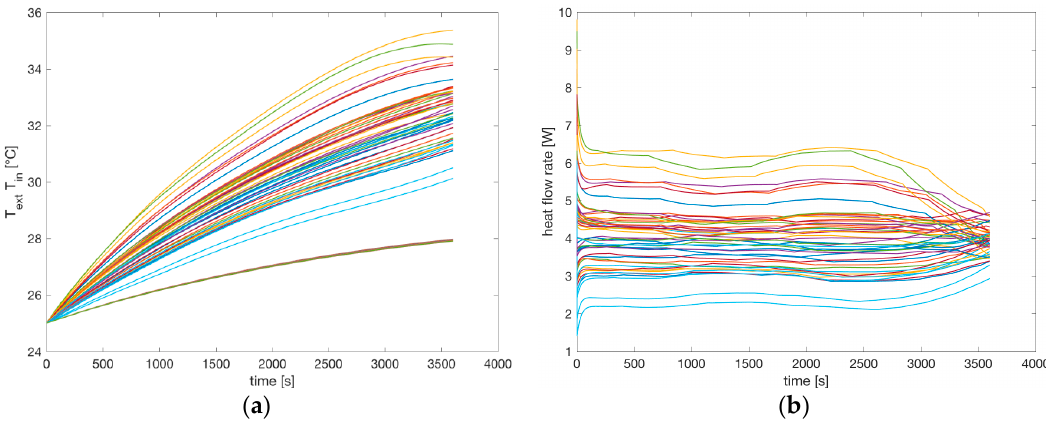
Figure 14. ( a ) 48 internal and 48 external temperatures of the cells; ( b ) heat flow rate of each cell.